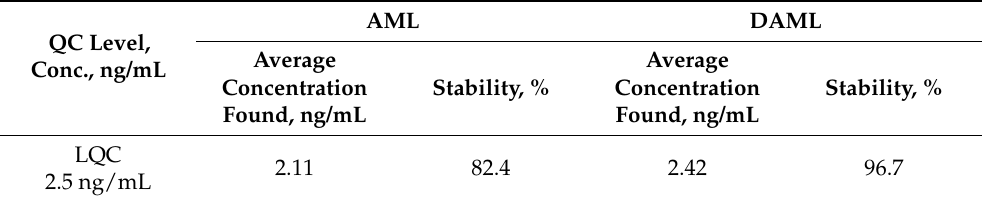
Table A9. Bench-top stability (4 h, room temperature) for AML and DAML spiked in human plasma. QC